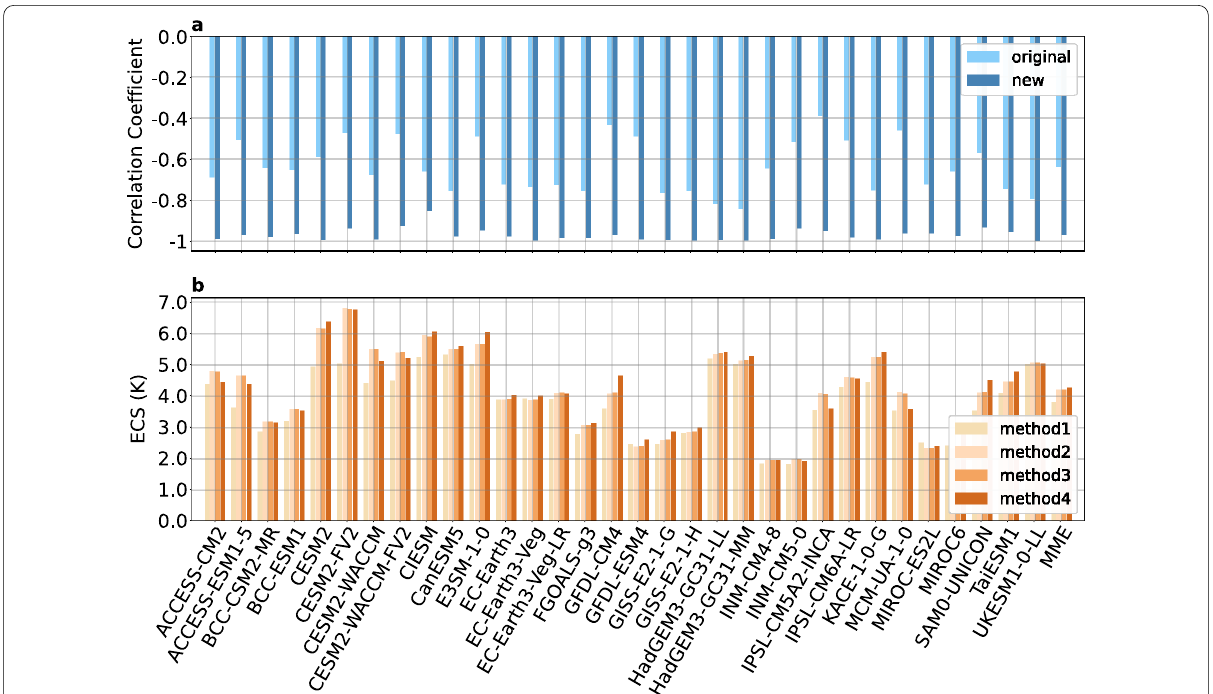
Fig. 6 a Correlation coefficient between the global-mean and annual-mean surface temperature anomalies (cid:31) T and TOA net radiative flux anomalies (cid:31) N from the 50th year (21st point) of the original (new) time series in the CMIP6 abrupt4xCO2 experiment (relative to piControl). b Comparison of ECS values estimated by four methods in CMIP6